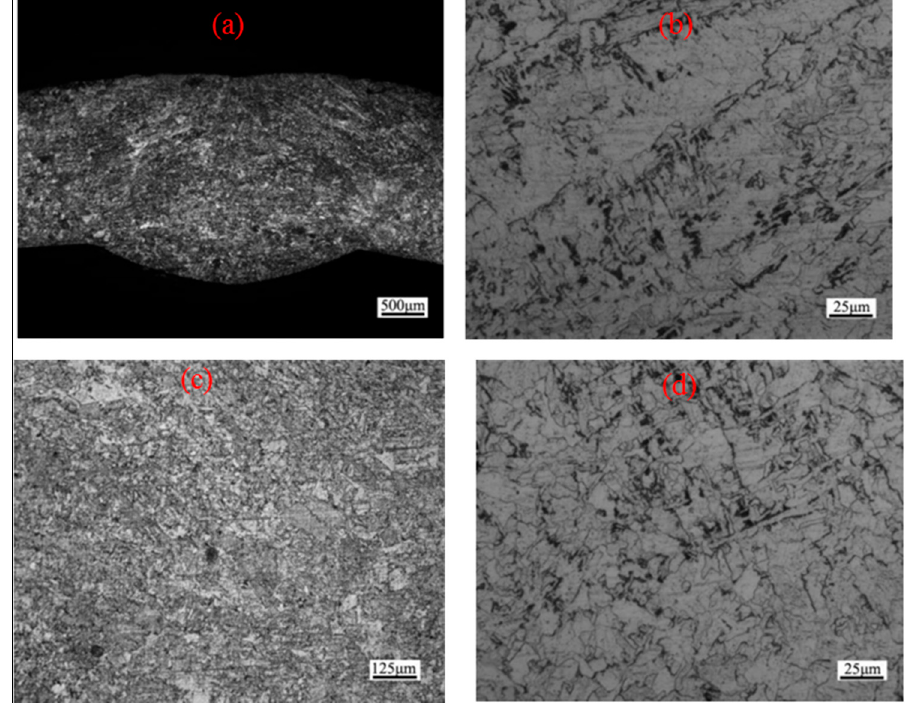
Figure 14. Microstructure of longitudinal weld after enameling ( a ) weld zone; ( b ) weld columnar grain; ( c ) fusion zone; and ( d ) heat affected zone.